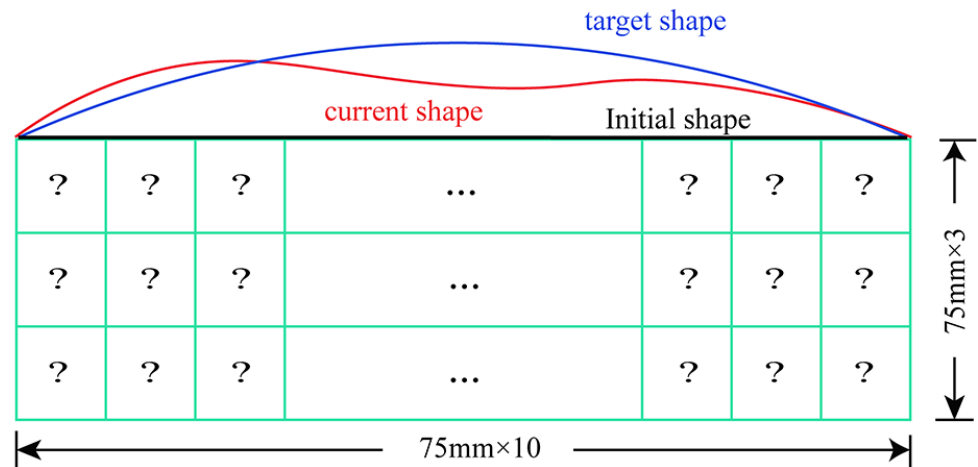
Figure 2. Two-dimensional schematic diagram of the design of the distributed variable thickness structure based on digital metamaterials.